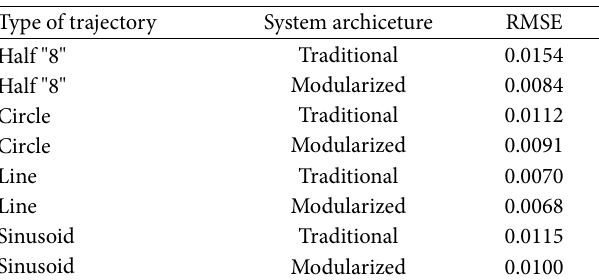
Table 2: The error analysis of